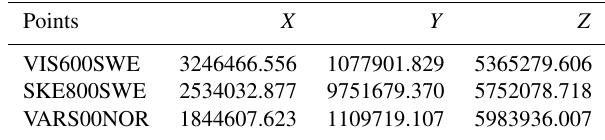
Table 1. Actual coordinates of